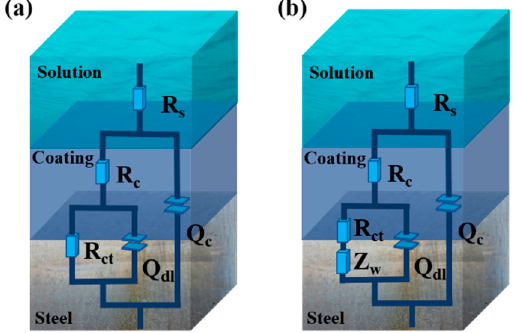
Figure 10. Schematic diagram of the equivalent circuit used to fit the EIS data. ( a ) diffusion of the corrosive medium to the coating-substrate interface; ( b ) with Warburg impedance. Table 1. Values of electrochemical corrosion parameters obtained by fitting EIS date.